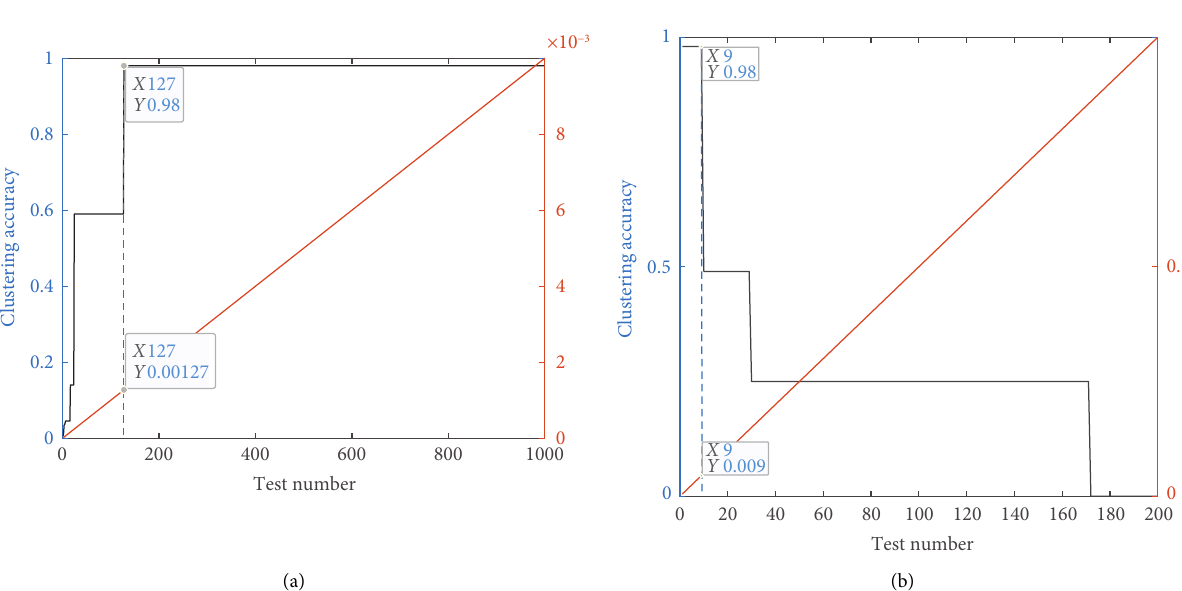
Figure 8: Clustering accuracy with different value of θ . (a) θ ∈ [ 10 − 5 , 0 . 01 ] ; (b) θ ∈ [ 0 . 01 , 0 . 2 ]